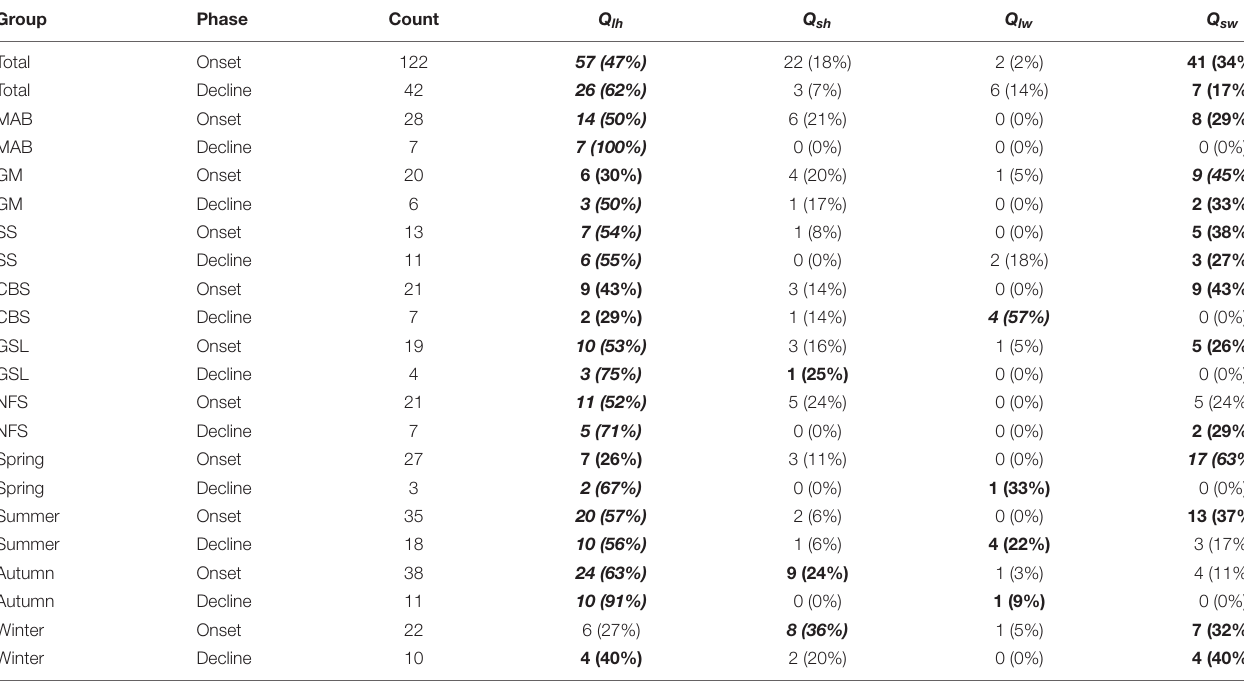
The columns show grouping of the MHWs (total, region, and season), followed by the time series phase (onset or decline) being shown in that row. The total count of MHWs is then shown followed by a column for the count of each T Qx variable that had the lowest RMSE when compared against SSTa. The highest count per row is shown in bold italics, with the second highest in bold. In the case of ties, no more than two values are highlighted. The percentage of the total count per row for each grid cell is shown in brackets for convenience. The region abbreviations are given in Figure 1